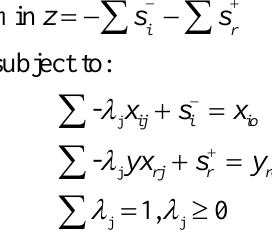
The summary of Kolmogorov-Smirnov test Var. Sig. Z Sig. Z Sig.